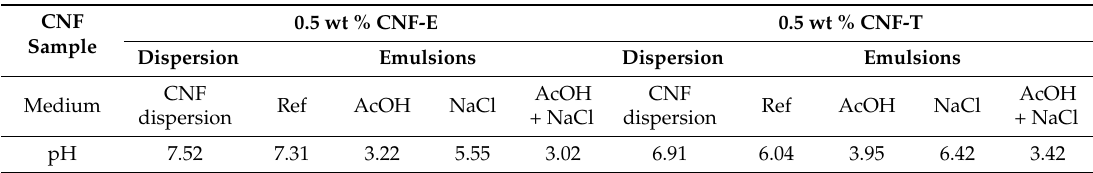
Table 4. Measured pH for CNF dispersions and for CNF-stabilized emulsions. The media are the following. Ref: deionized water; AcOH: 0.2 wt % acetic acid; NaCl: 1.0 wt % NaCl; AcOH + NaCl: 0.2 wt % acetic acid + 1.0 wt %